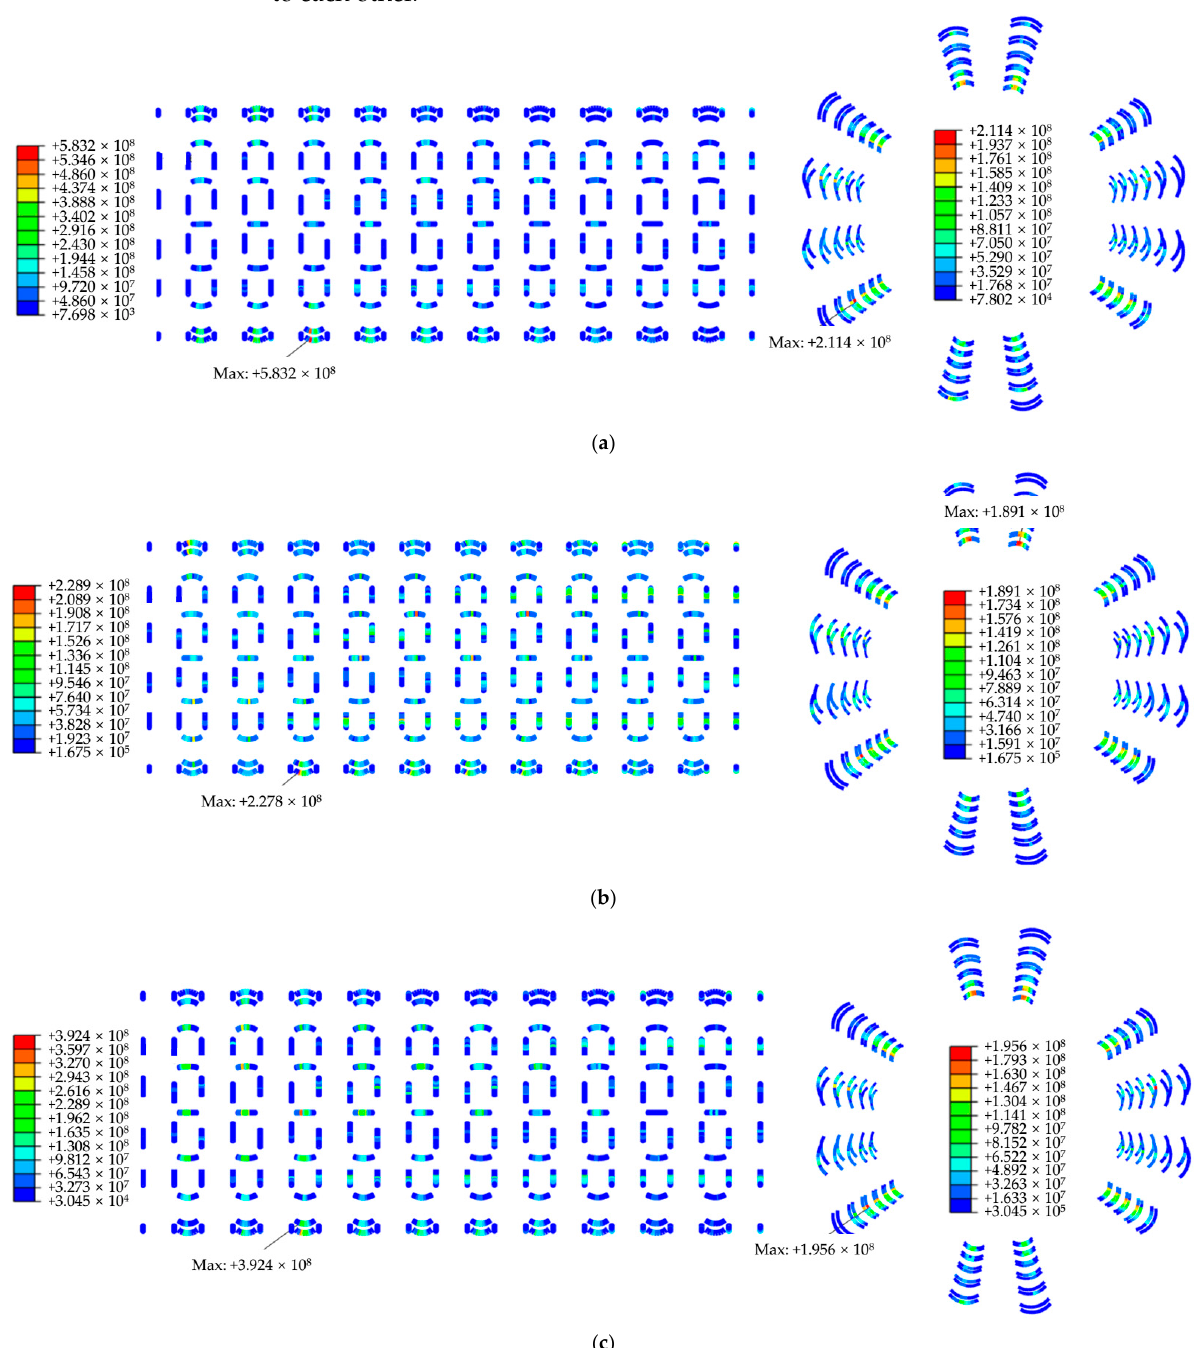
Figure 17. Stress of Bolts. ( a ) Upward direction of shield machine. ( b ) Downward direction of shield machine. ( c ) Left direction of shield machine.